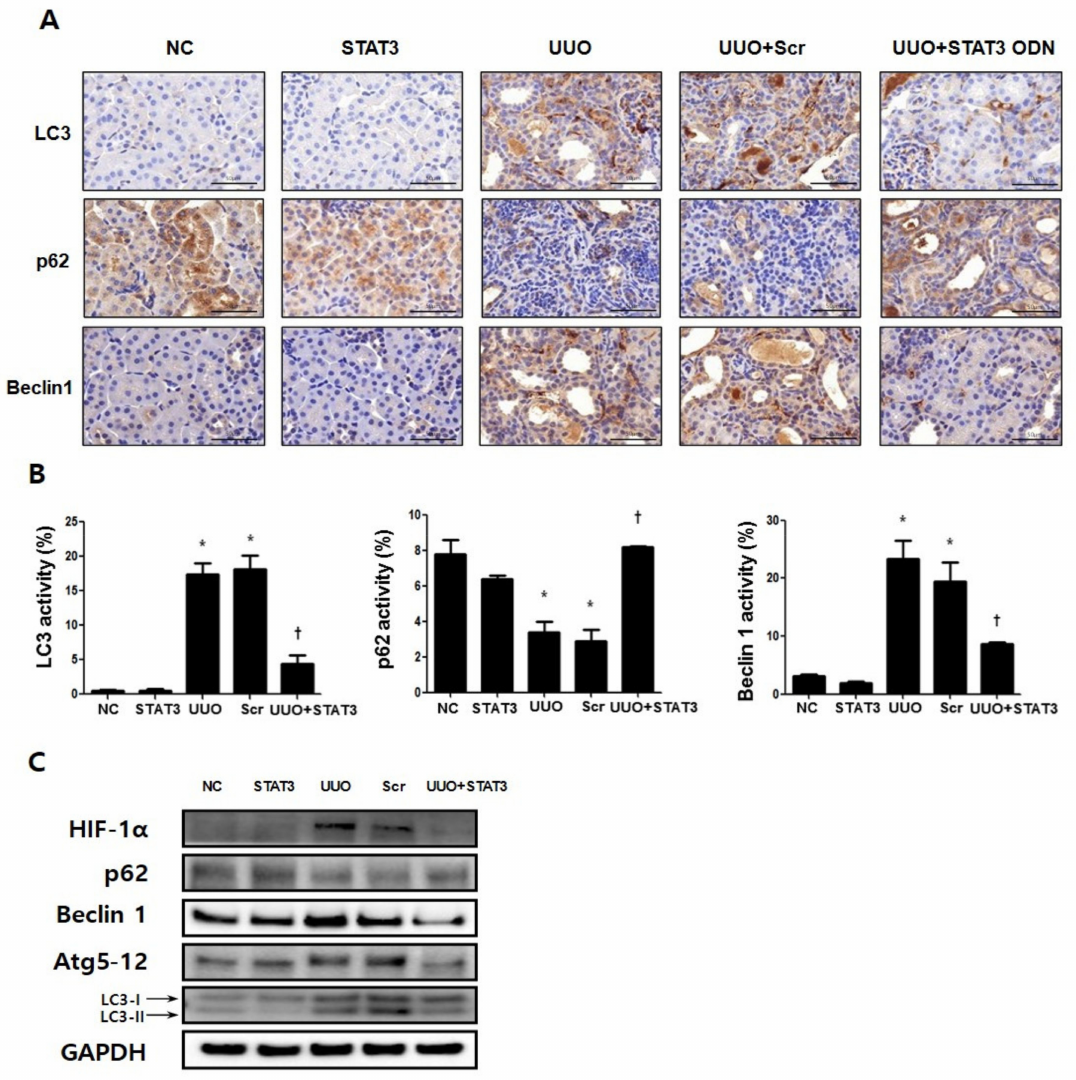
Figure 5. Regulation Effects of Autophagy by STAT3 Decoy ODNs. The STAT3 decoy ODNs suppress autophagy in UUO. ( A ) Immunohistochemical staining shows that autophagy is inhibited by STAT3 decoy ODN. LC3 and Beclin1, autophagy markers, increase in UUO. Autophagosome marker, p62, decreases in UUO. Immunohistochemical staining was used to evaluate the extent of autophagy, which was subsequently quantified ( n = 3) at a magnification of 400X. ( B ) The graphs show the percentage of LC3, p62 and Beclin1 positive area. ( C ) The representative image of the Western blot analysis shows that STAT3 decoy ODN inhibits autophagy formation. * p < 0.05 vs. NC, † p < 0.05 vs. UUO. Abbreviations: UUO, unilateral ureteral obstruction; decoy ODNs, decoy oligonucleotides; STAT3, signal transducer and activator of transcription 3; Scr, scrambled; LC3, microtubule-associated protein light chain 3; Atg5-12, autophagy-related 5-12; HIF-1 α , hy-poxia inducible factor-1 α